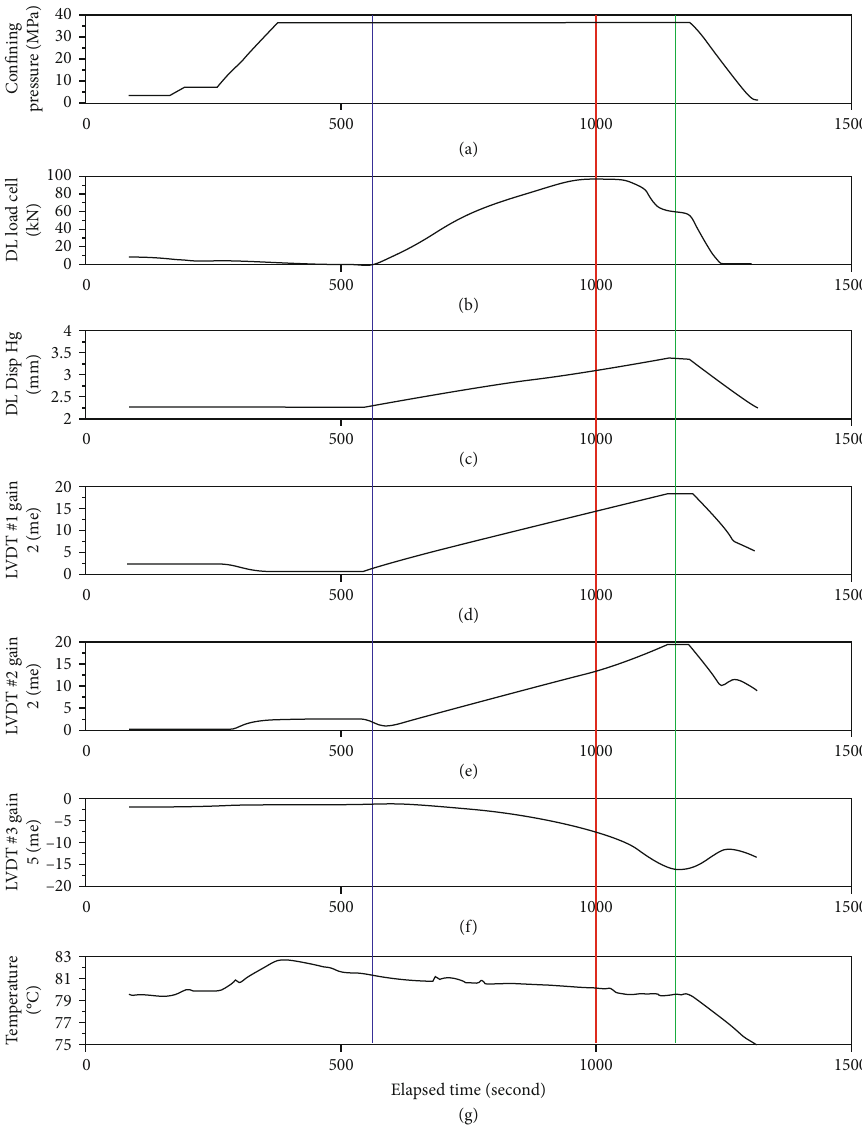
Figure 2: Bursting pressure experiment process of the constant strain rate method.